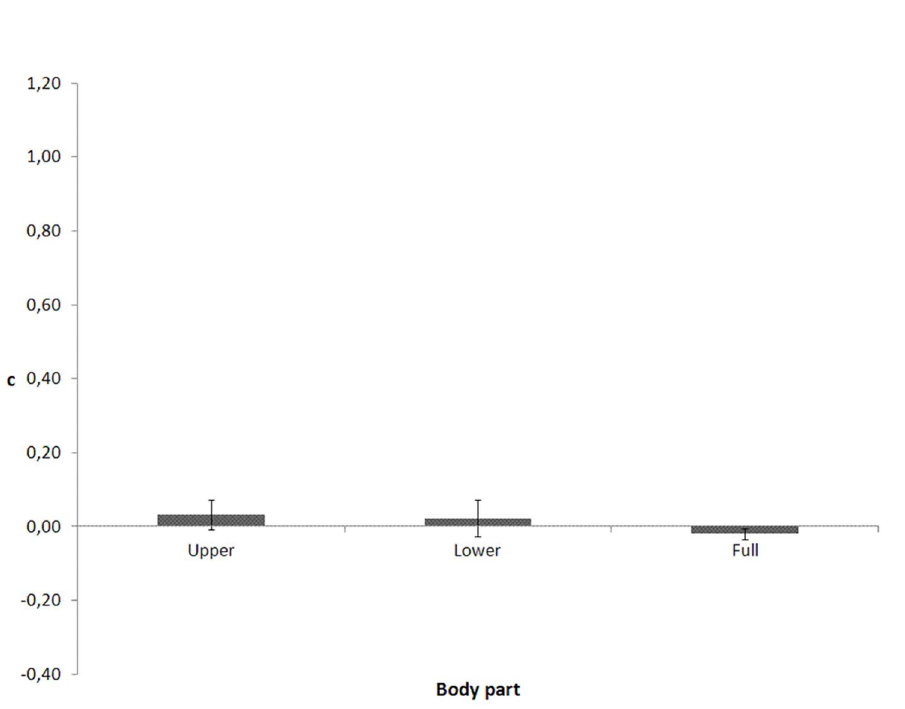
Fig. 2. c as a function of visible body part for the walking action in Experiment